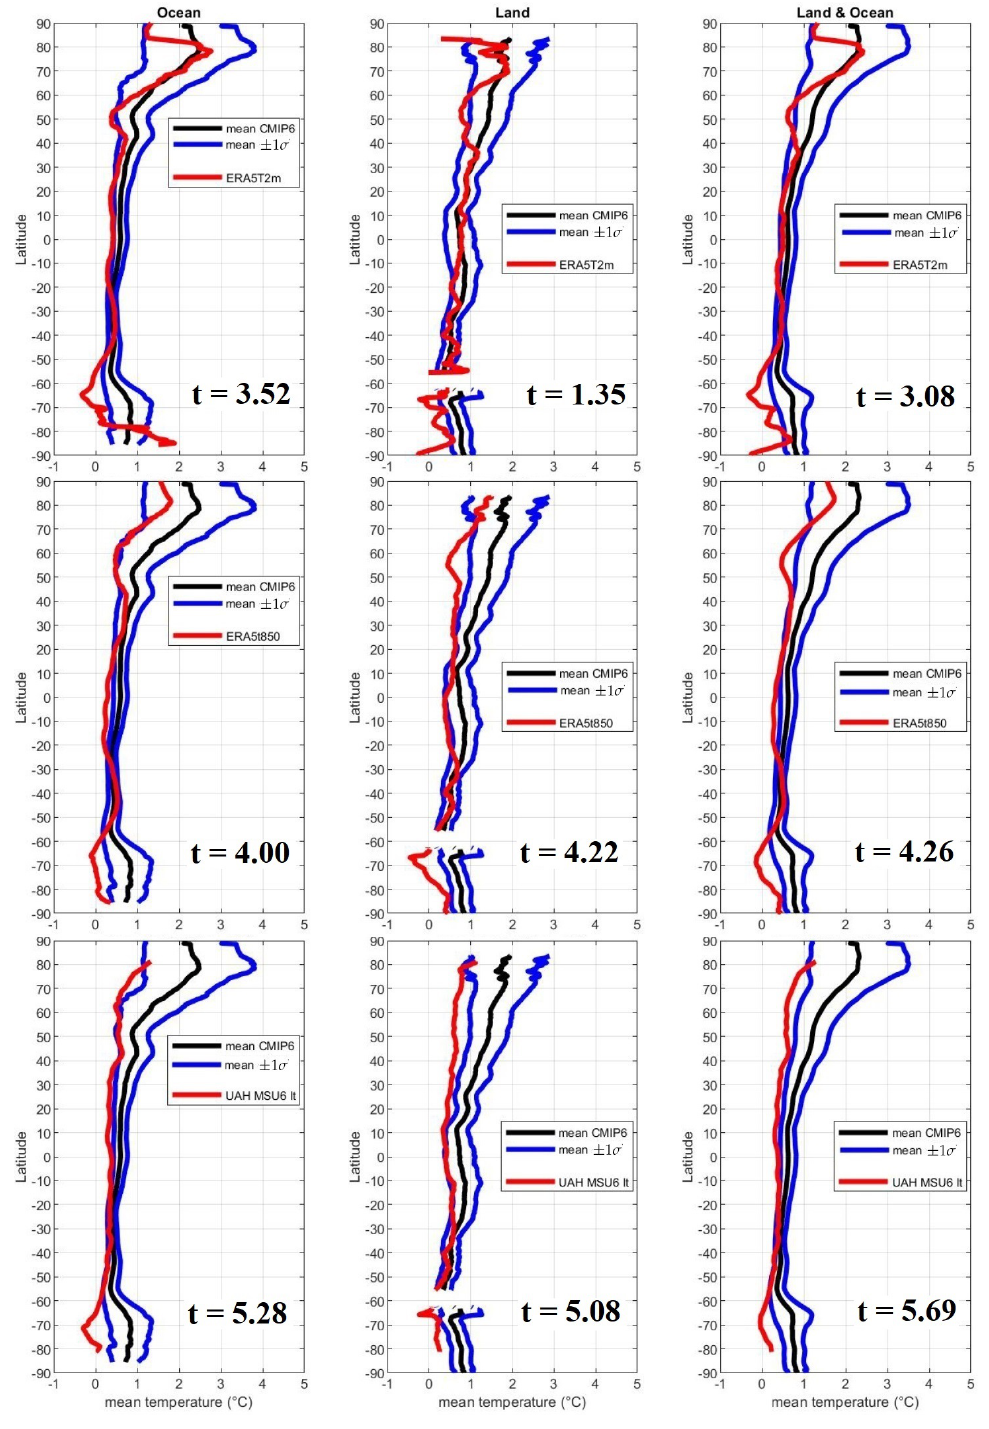
Figure 7. Latitudinal warming profile from 1980–1990 to 2011–2021 produced by three adopted temperature records (ERA5-T2m, ERA5-850mb, and the UAH MSU v6.0 Tlt) (red curves) against the CMIP6 models: their average profile (black curves) plus/minus one standard deviation of the model ensemble ( ± 1 σ ) (blue curves). Each panel also reports the mean Student t -test value for each case calculated by averaging the values for each latitude. A model-data agreement can be rejected at the significance level 0.05 when t ≥